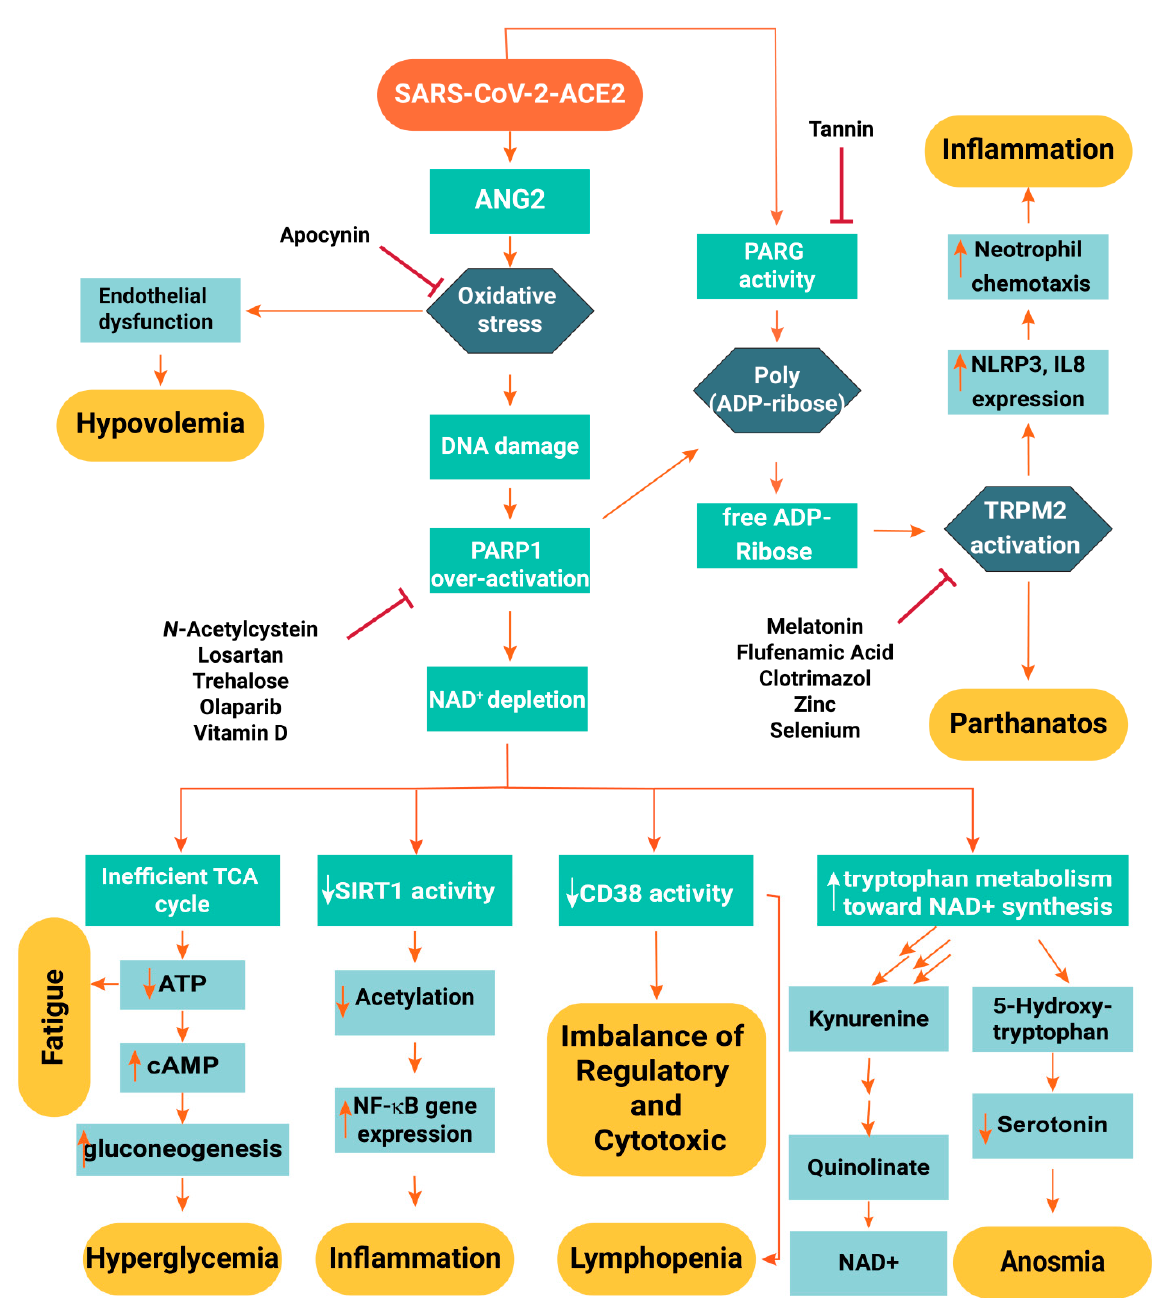
Figure 8. Flowchart of the SARS-CoV-2 pathogenesis and the purported antiviral mechanisms of clinical medications used for combating COVID-19.